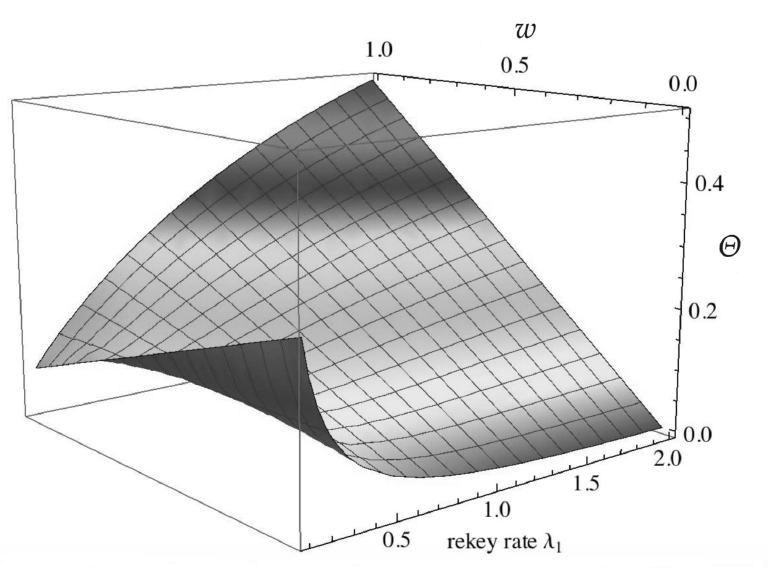
Figure 5. Θ over rekeying rate λ 1 and weighting parameter w